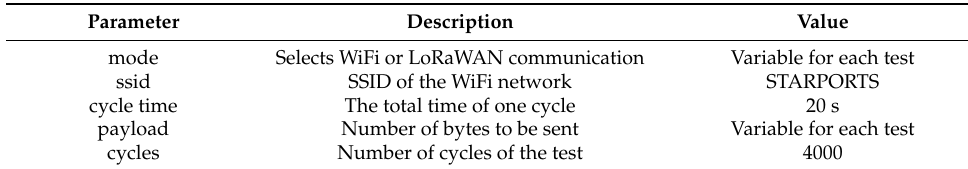
Figure 11. Sensor node software flowchart. Table 3. Configuration parameters from the flash